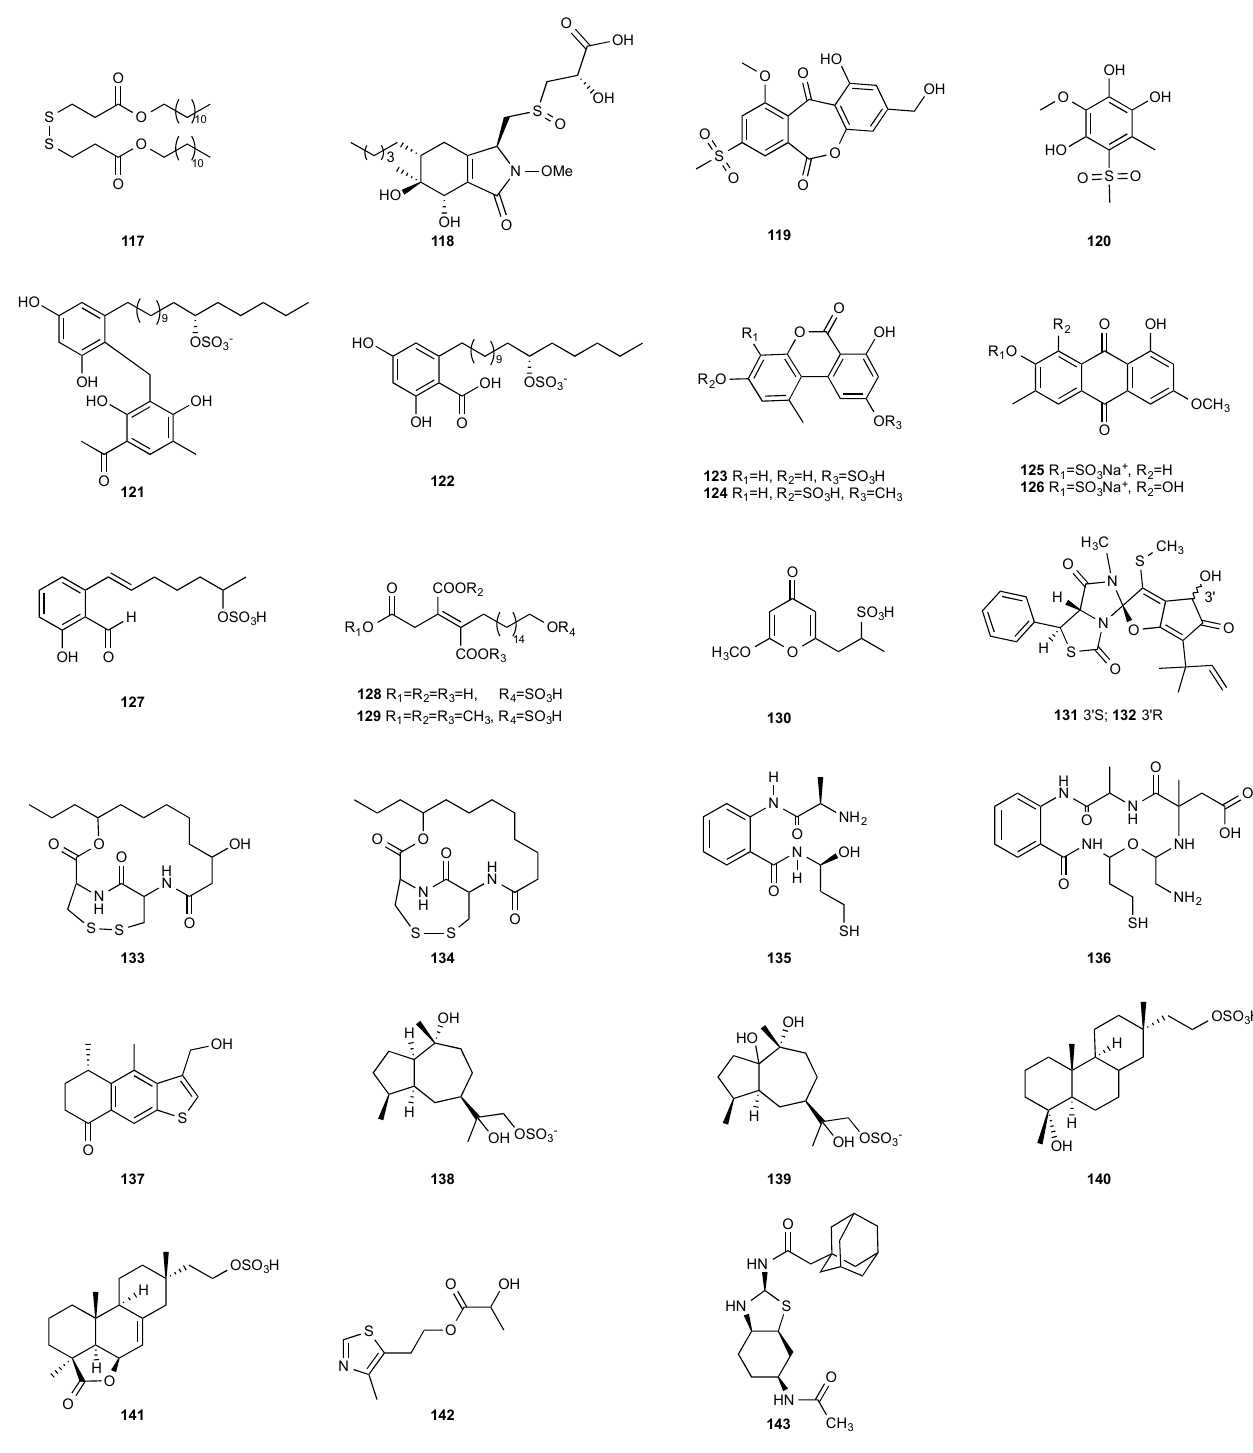
Figure 5. Structures of compounds 117 – 143 .